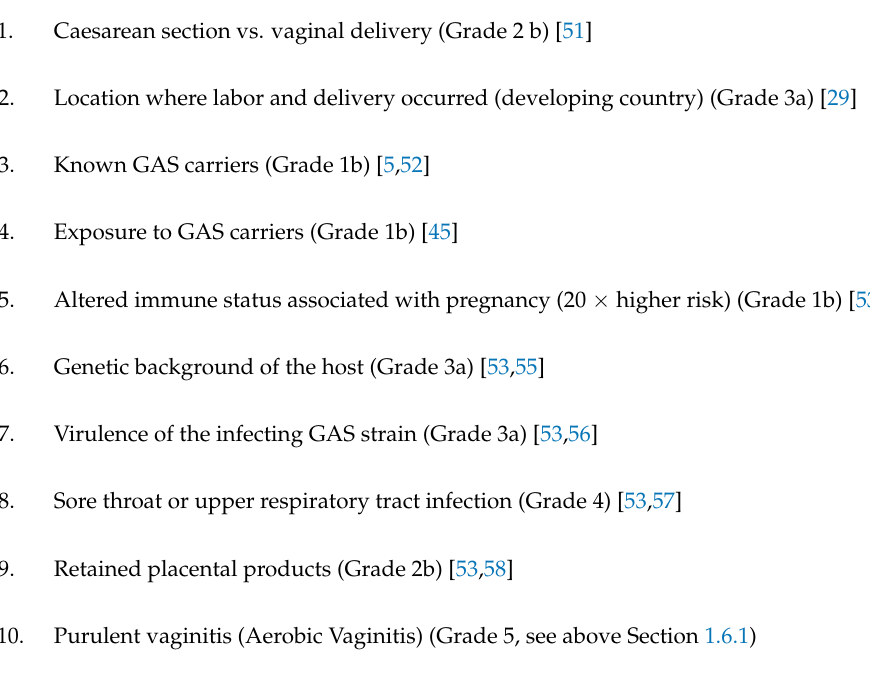
Table 5. Risk factors of iGAS infection in an obstetrical